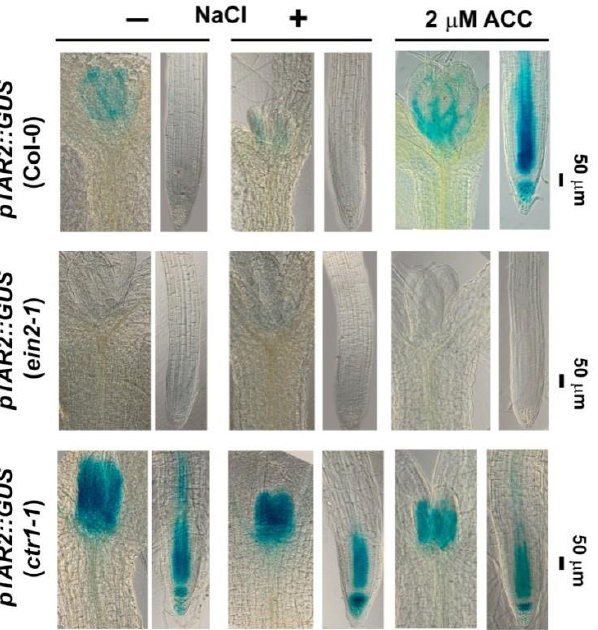
Figure 3. Staining patterns of pTAR2::GUS in roots and shoots of the wild type Col-0 and homozygous (F3) ctr1-1 and ein2-1 plants subjected to 100 mM NaCl treatment for 48 h. The pTAR2::GUS expression pattern in six-day-old plants grown on media supplemented with 2 µM 1-aminocyclopropane-1-carboxylic acid (ACC) is shown.